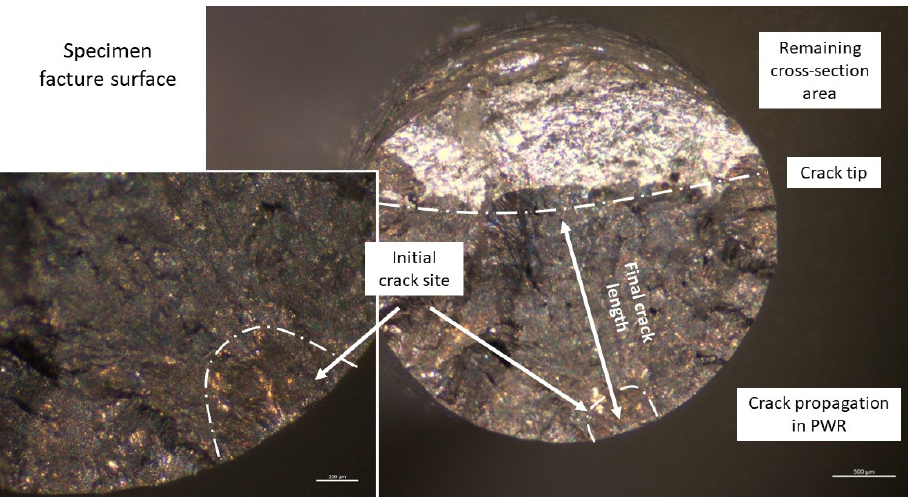
Figure 5. Specimen fracture surface after testing in a PWR environment. Then, coupling the signal of the DCPD signal over time and the crack growth geo ‐ metrical model allowed an estimation of the crack length as a function of the number of cycles (or test time) to be obtained, as shown in Figure 6. Fitting the 1/S r curve up to the maximum crack length observed at the end of the test with the maximum value of the potential drop signal ( Δ V), it was possible to derive a correlation between the DCPD sig ‐ nal and the instantaneous crack length. The complete steps are as follows: